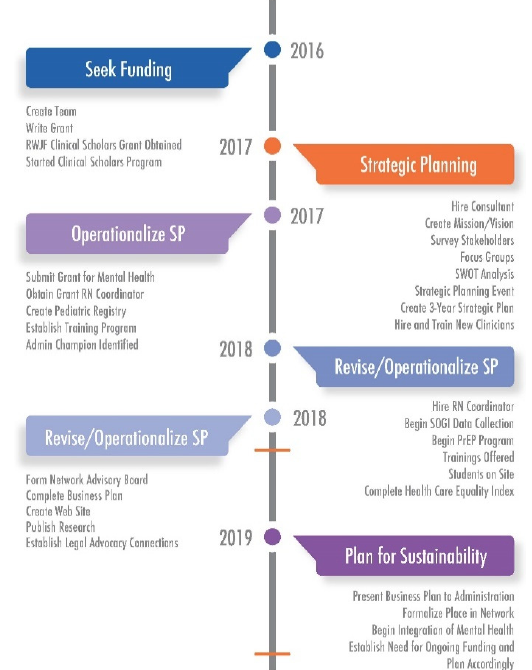
Figure 2. Timeline for implementing the COE. Figure originally published in “Leading Community Based Changes in the Culture of Health in the US: Experiences in Developing the Team and Impacting the Community (9).” Horizontal, orange lines represent the timing of baseline (2018) and follow-up (2019)